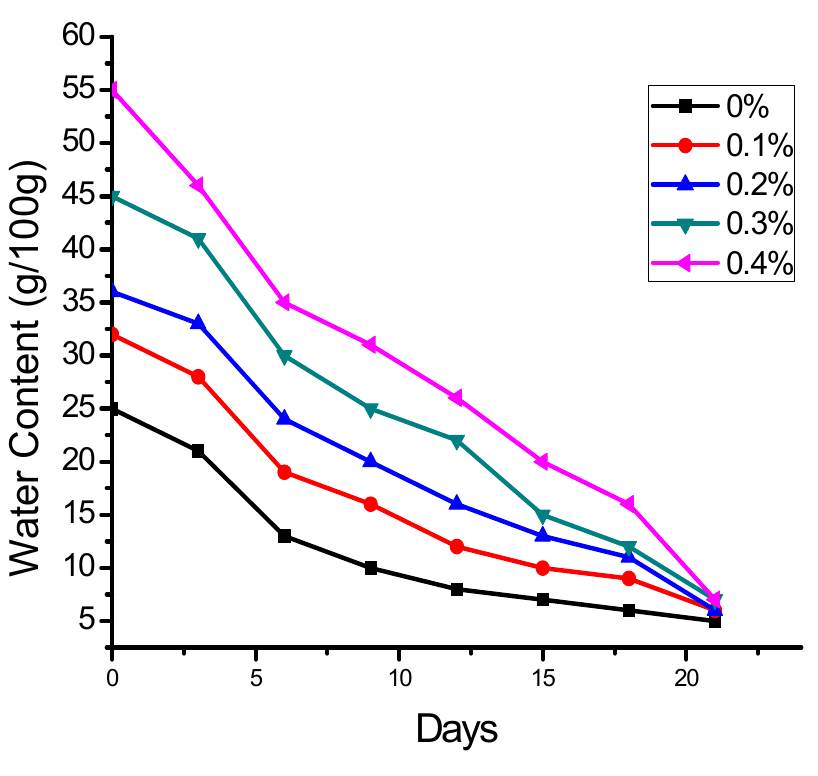
Figure 6. Water retention by the soil amended with different levels (0.1, 0.2, 0.3, 0.4%) of SHNC at field